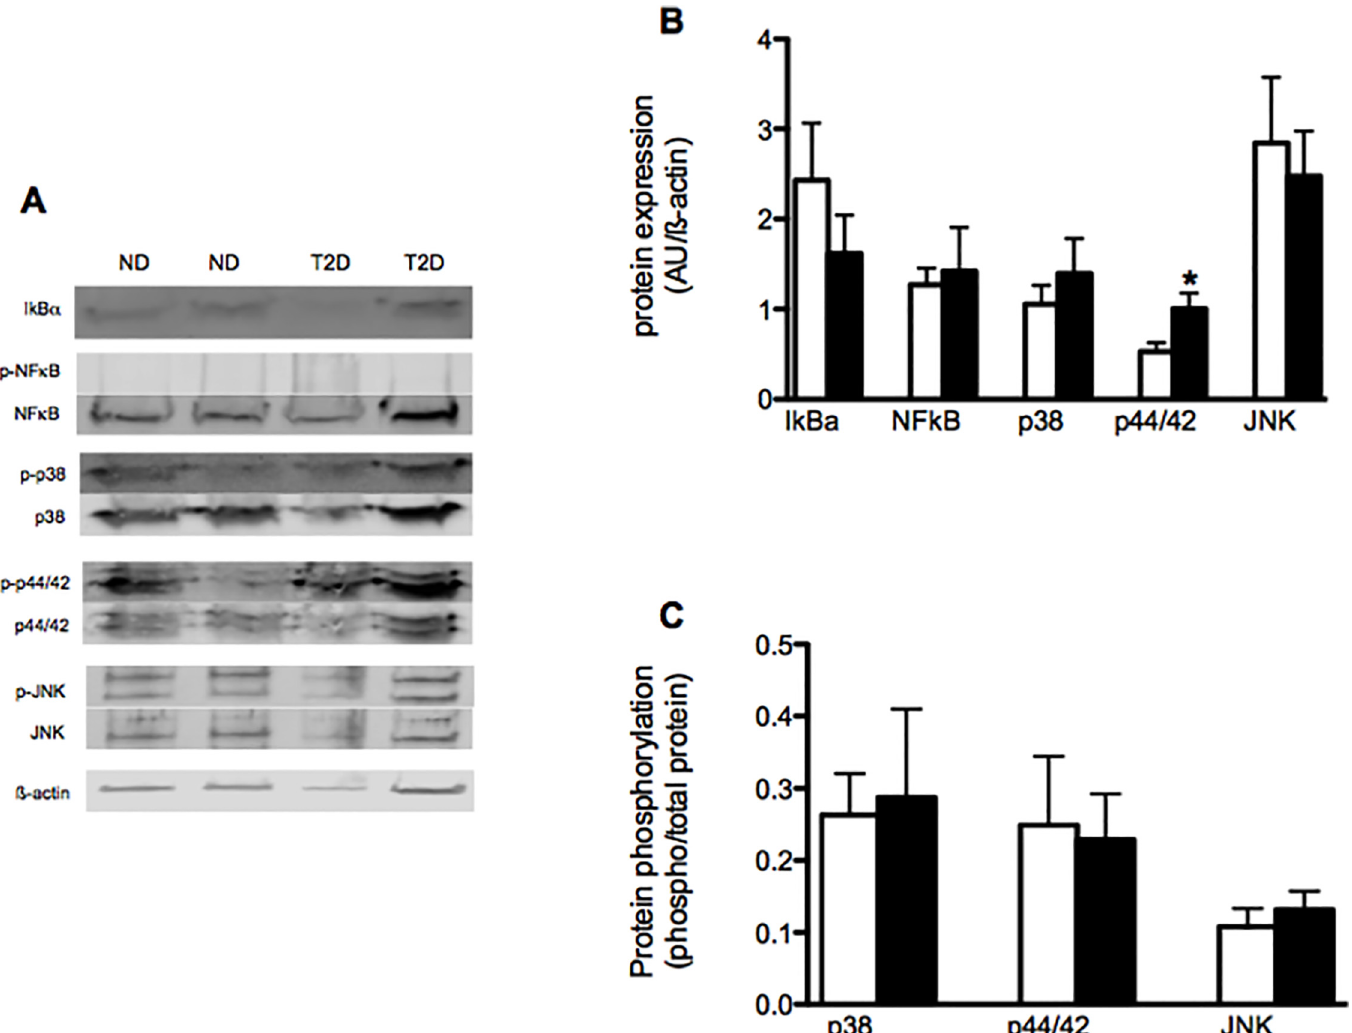
Fig 4. Impact of T2D on inflammatory signaling in hSMC. Proteins extracted from ND (open bars) and T2D (solid bars) hSMC under control conditions. (A) Representative western blots. (B) Quantification of protein expression normalized to loading control (ß-actin). Ave + SEM, n = 13 – 21 for ND, 10 – 16 for T2D. (C) Protein phosphorylation, expressed as ratio of phosphorylated to total protein. Ave + SEM, n = 13 – 17 for ND, 9 – 15 for T2D. * p < 0.05 vs ND